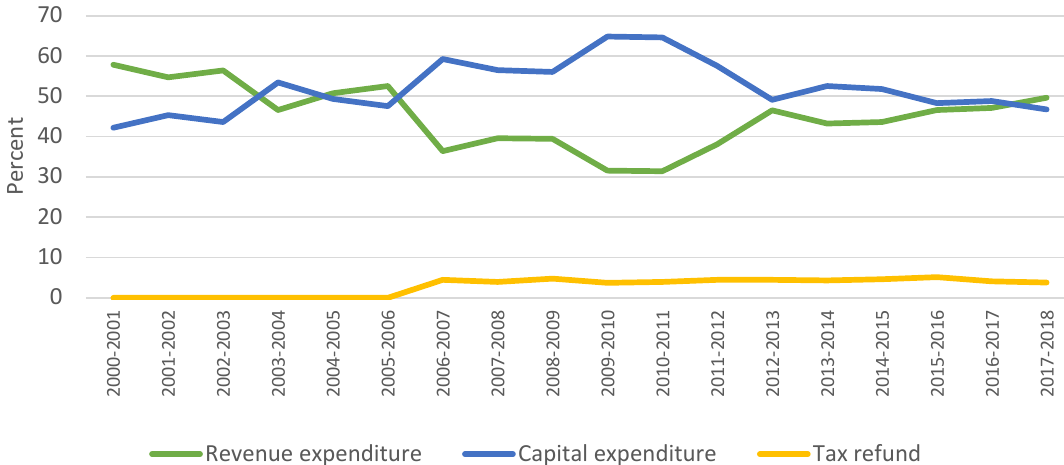
Source: From 2000 to 2018 NMMC